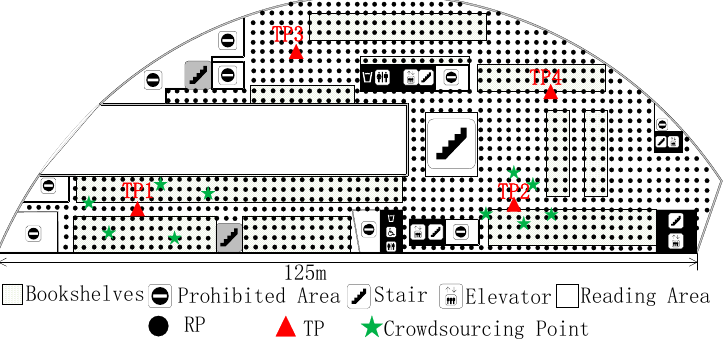
Figure 10. Ten crowdsourcing-based points around TP1 and TP2, away from TP3 and TP4. Sensors 2018 , 17 , x FOR PEER REVIEW